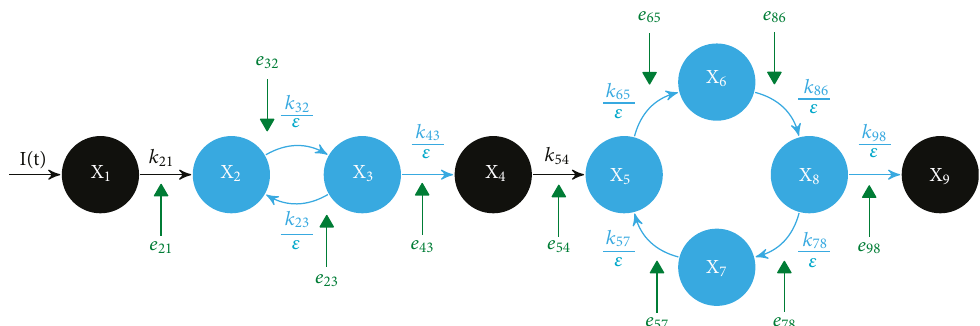
Figure 3: We consider that reactions represented by black arrows are slow, while reactions represented by blue arrows are fast. Metabolites in black are accumulative, whereas metabolites in blue are nonaccumulative and they are supposed to be in quasi-steady state. Every reaction is catalyzed by an enzyme e ji